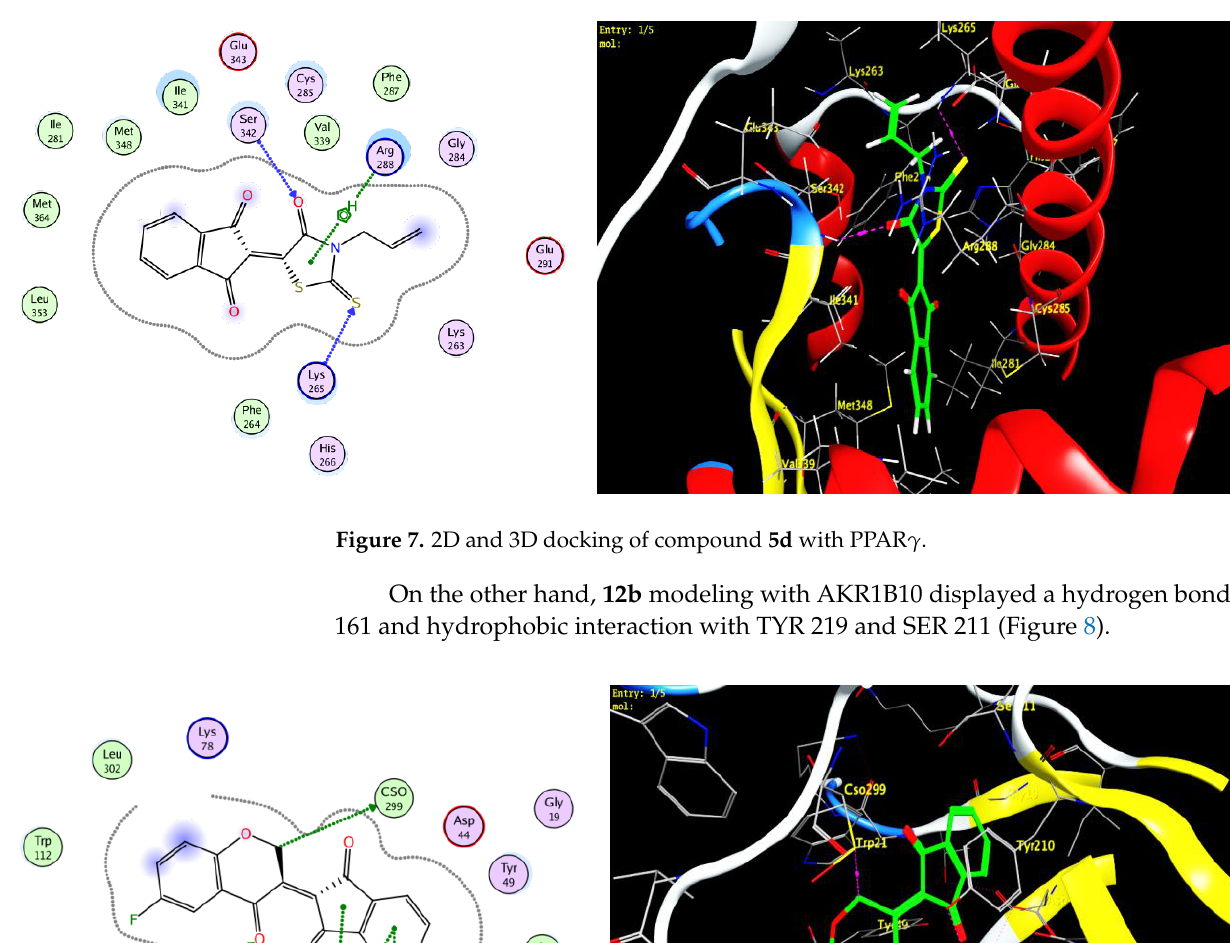
drophobic interaction with ARG 288 (Figure 7).